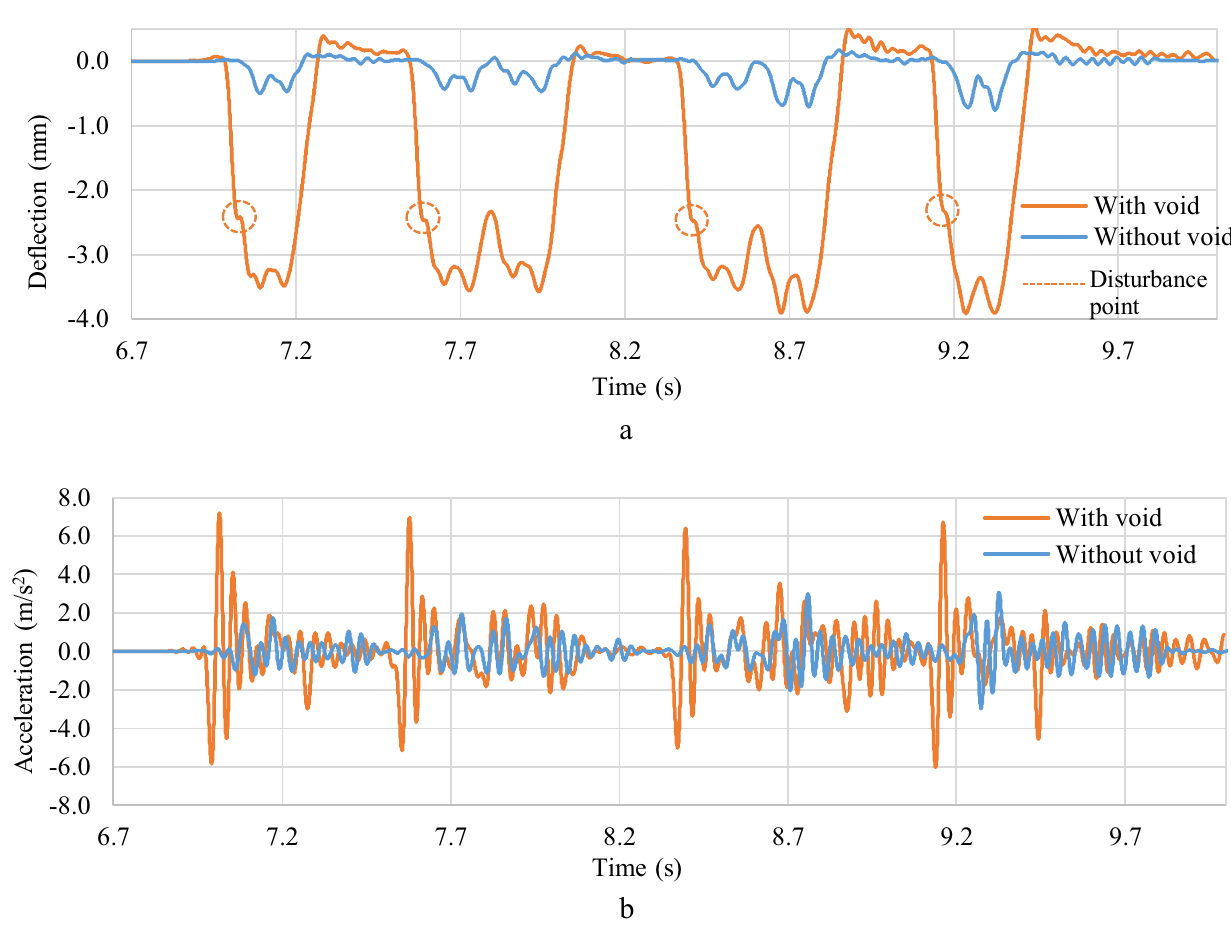
Fig. 5 Measured rail deflections ( a ) and accelerations derived from LVDT ( b ) in the voided zone (case 2) and the reference